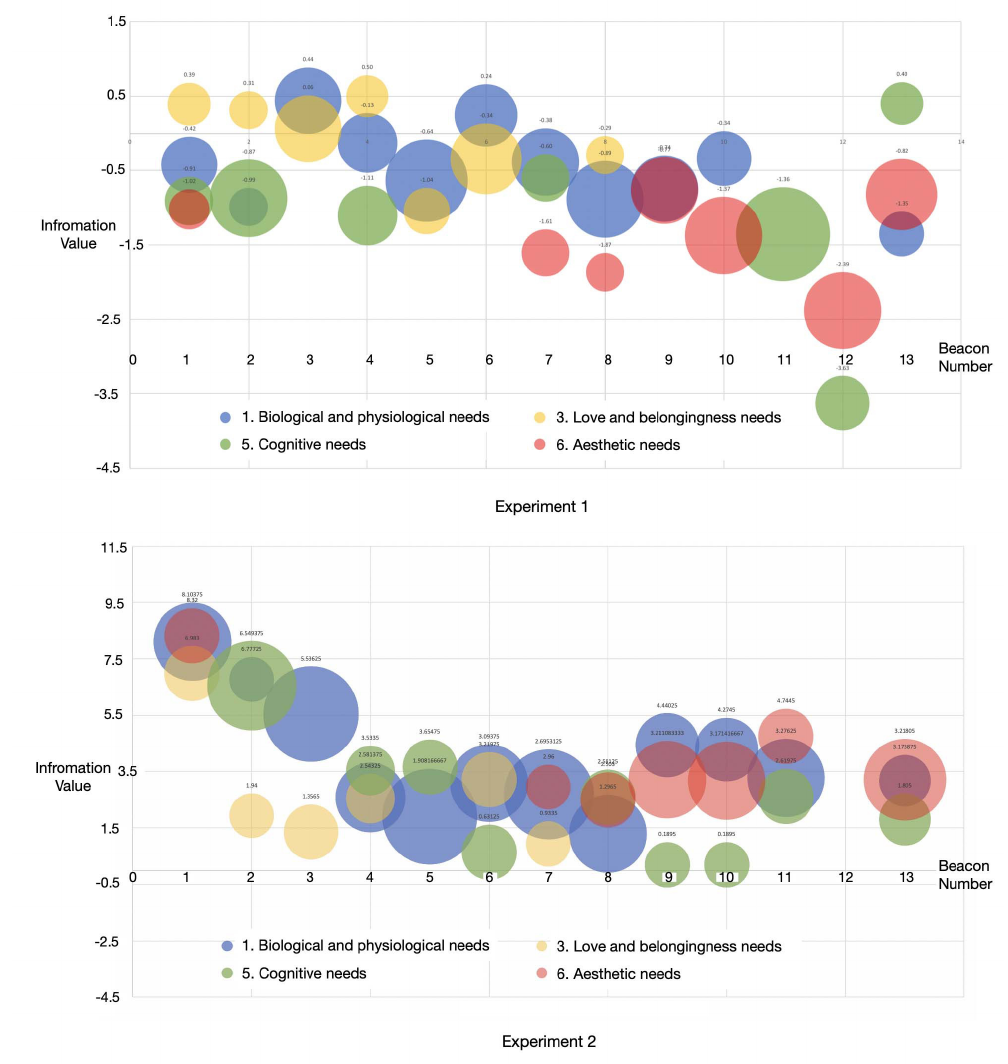
Figure 20. Bubble chart of the information value.